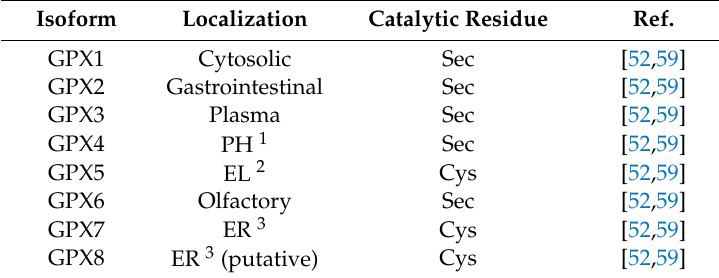
Table 1. Glutathione peroxidase (GPx) isoforms in mammalian cells.